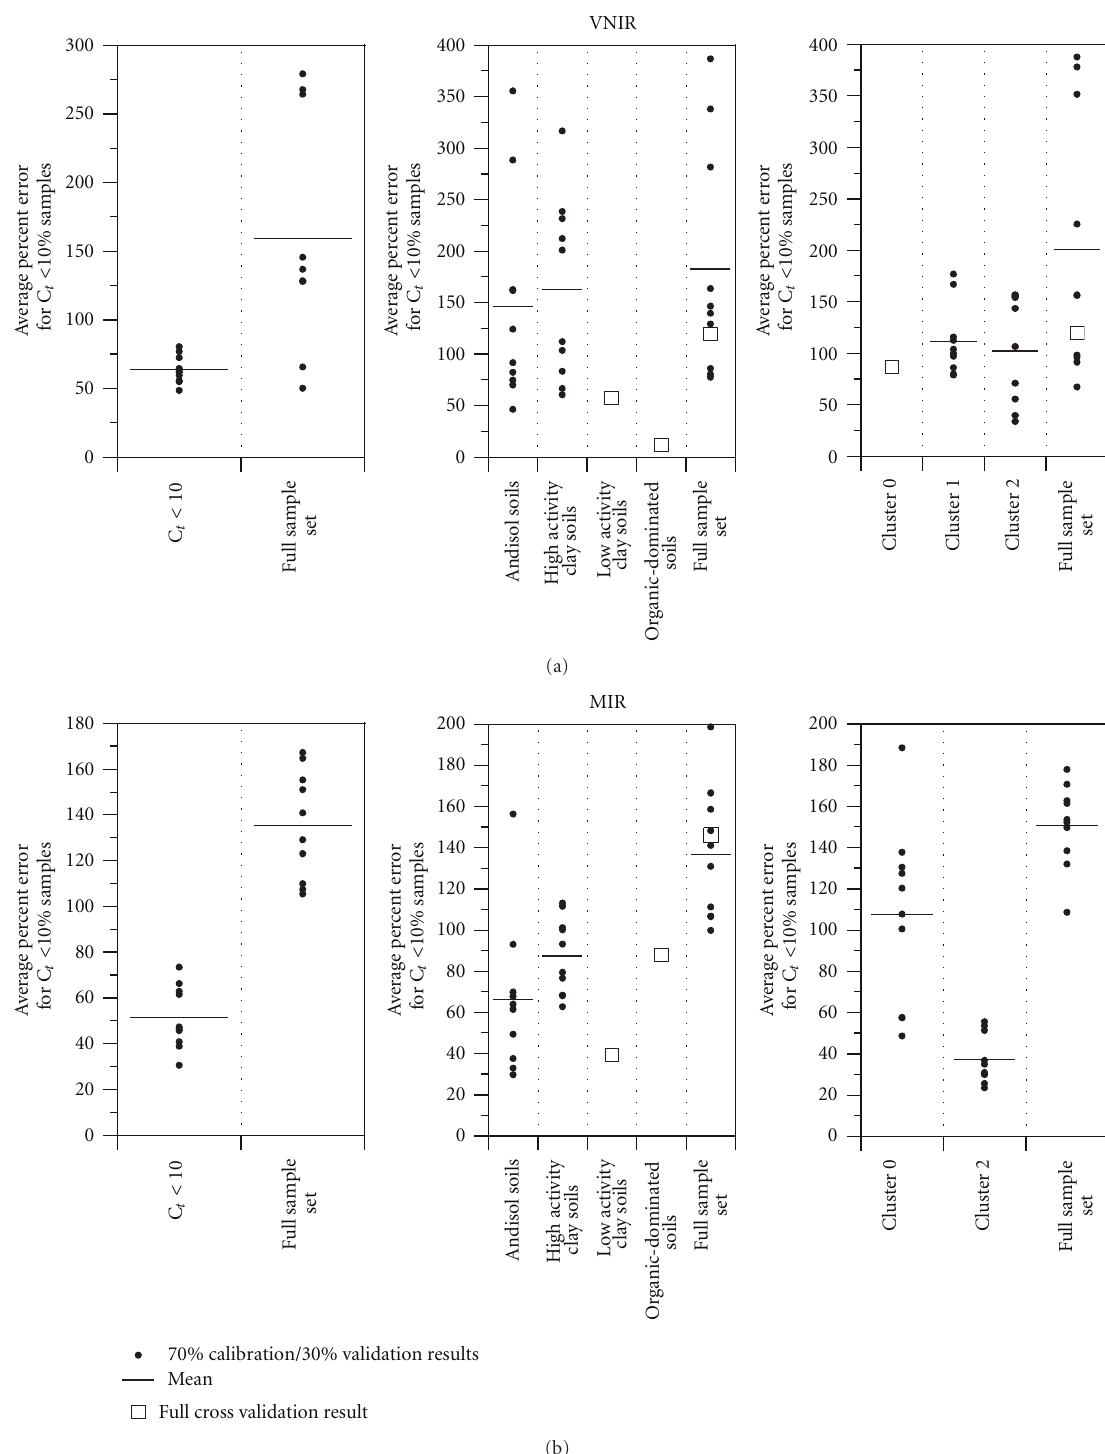
Figure 6: Average percent error of the C t < 10% portion of the (a) visible/near-infrared (VNIR) and (b) mid-infrared (MIR) subset and full sample set models in this study. The range of values reflects the results of 10 random iterations of the models. The VNIR and MIR high C t models and the MIR Cluster 1 models were not included because all samples had C t >